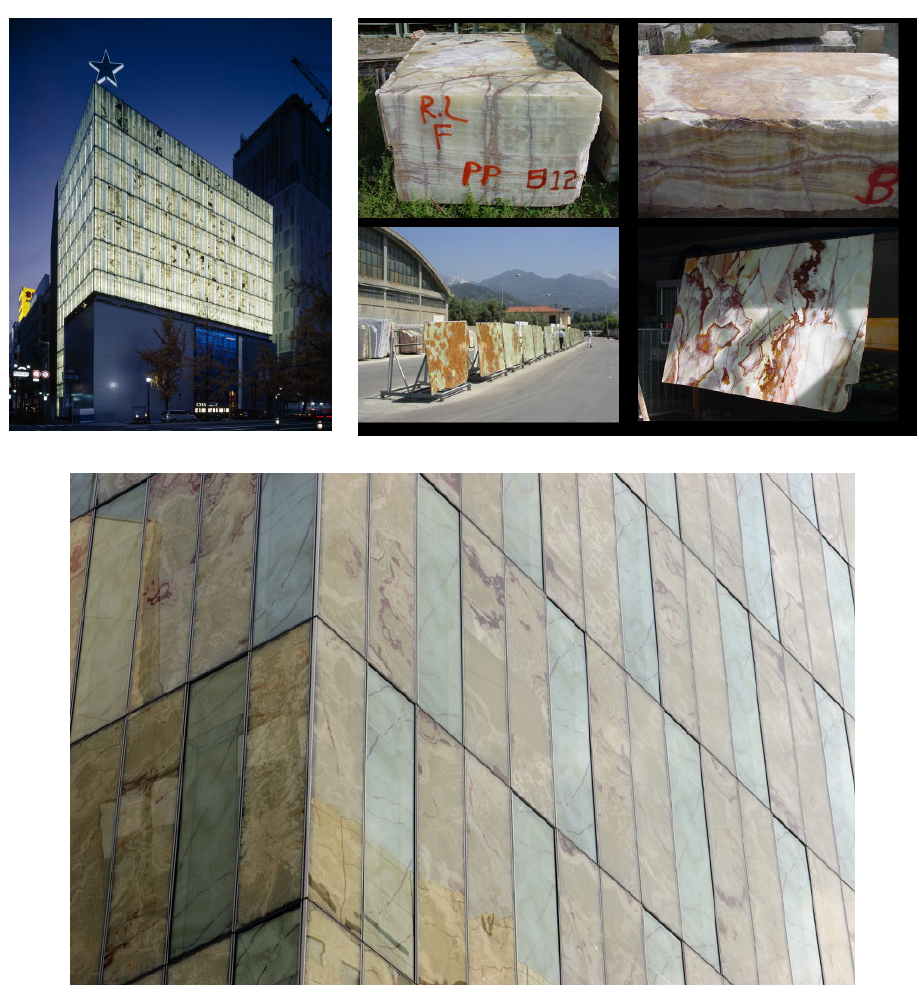
Figure 3a, b, c: LVMH Osaka Façade, Persian Green Onyx Blocks 7 Slabs, Façade Corner